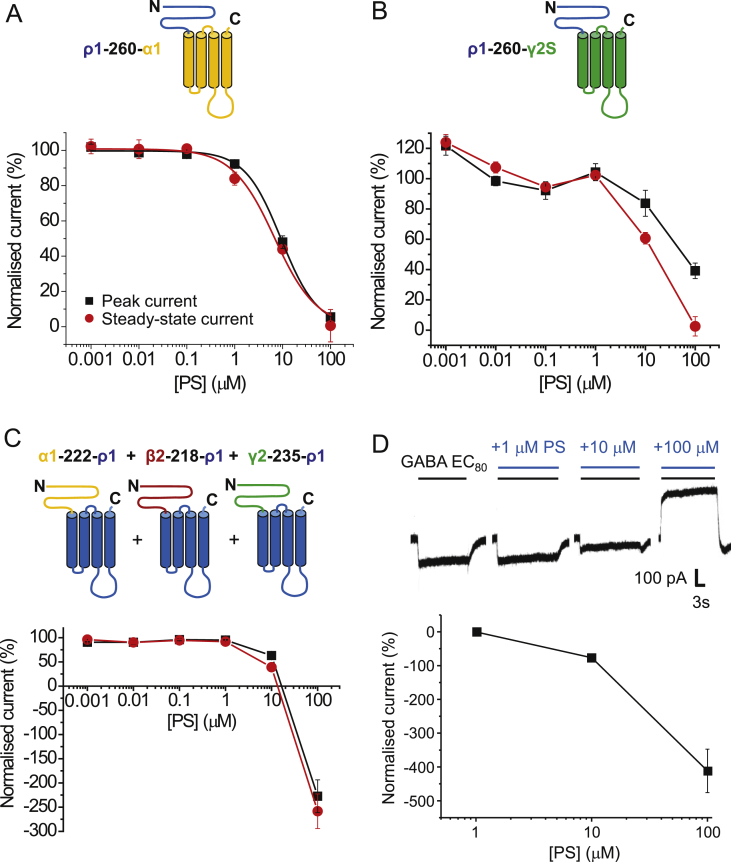
Inhibition by PS at three ECD-TMD GABAAR chimeras.(A) Schematic diagram (upper panel) of the transmembrane topology for the ρ1-260-α1 chimera in which the ECD is taken from ρ1 (blue) and the TMD and linkers are from α1 (orange). The lower panel shows PS inhibition data for GABA EC80 (30 μM) peak and steady-state currents (n = 5). (B) Schematic (upper panel) for ρ1-260-γ2S chimera in which the ECD from ρ1 (blue) is fused to the TMD from γ2S (green). Lower panel shows PS inhibition data for GABA EC80 (200 μM) peak and steady-state currents (n = 5). (C) Upper panel depicts a heteromeric chimera composed of: α1-222-ρ1 + β2-218-ρ1 + γ2-235-ρ1 subunits. ECDs are from α1 (orange), β2 (dark red) and γ2 (green), and the TMD is from ρ1 (blue) for all chimeras. Lower panel shows PS inhibition data for GABA EC80 (1 μM) peak and steady-state currents (n = 9). The negative normalised current describes inhibition by 100 μM PS of the constitutive channel activity. Data are expressed as mean ± SEM. (D) Upper panel shows examples of PS inhibition of GABA-activated (inward) and constitutively-active (outward) currents for the heteromeric α1-222-ρ1 + β2-218-ρ1 + γ2-235-ρ1 chimeric receptor. Lower panel shows PS inhibition concentration data for the constitutively-active current.